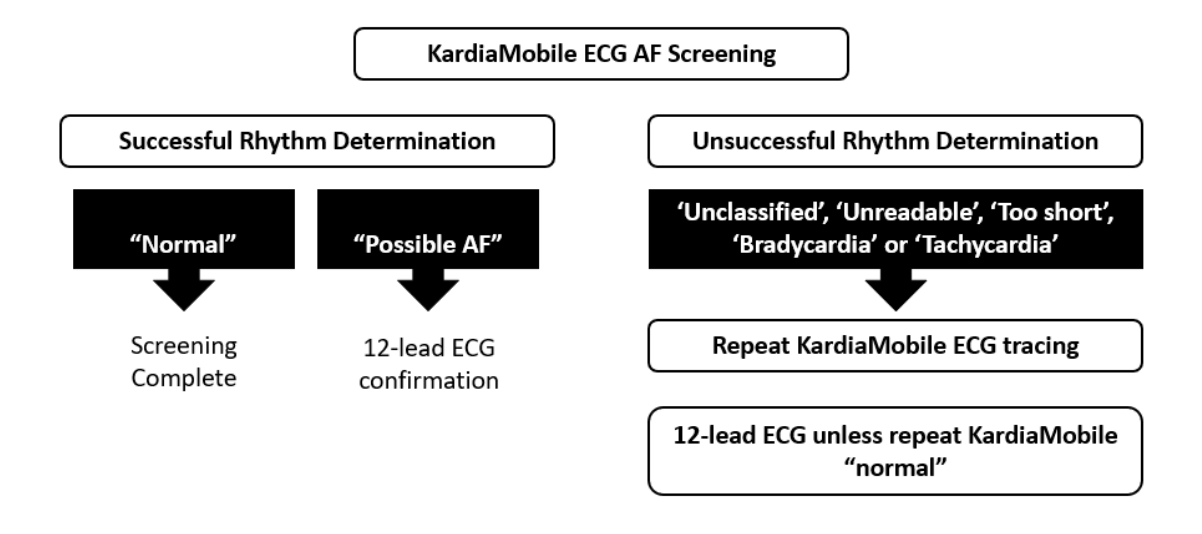
Figure 2. Atrial fibrillation (AF) screening protocol. ECG: